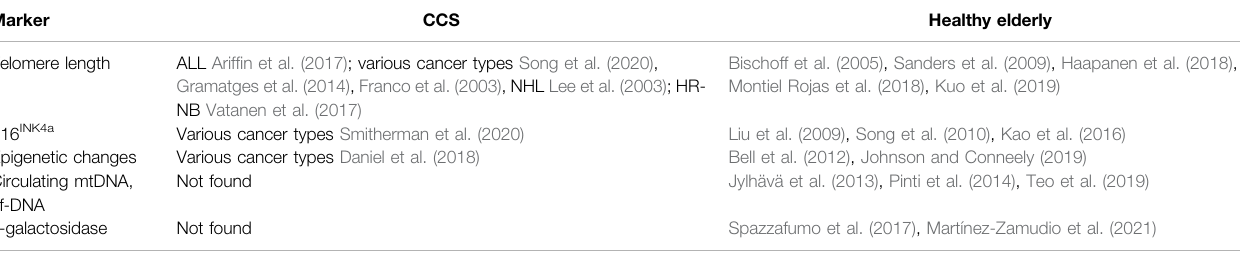
TABLE 4 | Systemic markers of senescence/aging in peripheral blood cells and